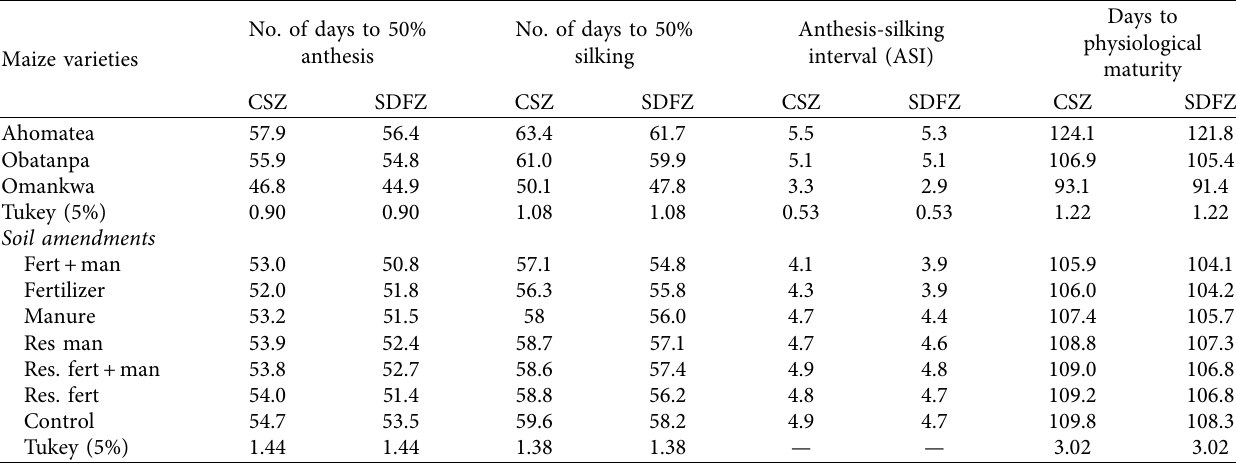
Control No.: number; Fert+Man: fertilizer+manure. Table 7: Phenology of three maize varieties as infuenced by diferent soil amendments and their residual efects in the coastal savannah (CSZ) and semi deciduous forest zone (SDFZ) in the minor cropping season. Maize